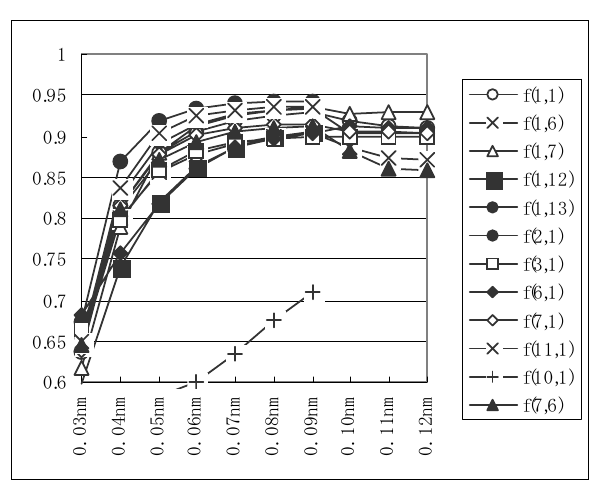
(D) Biological Activity 13.